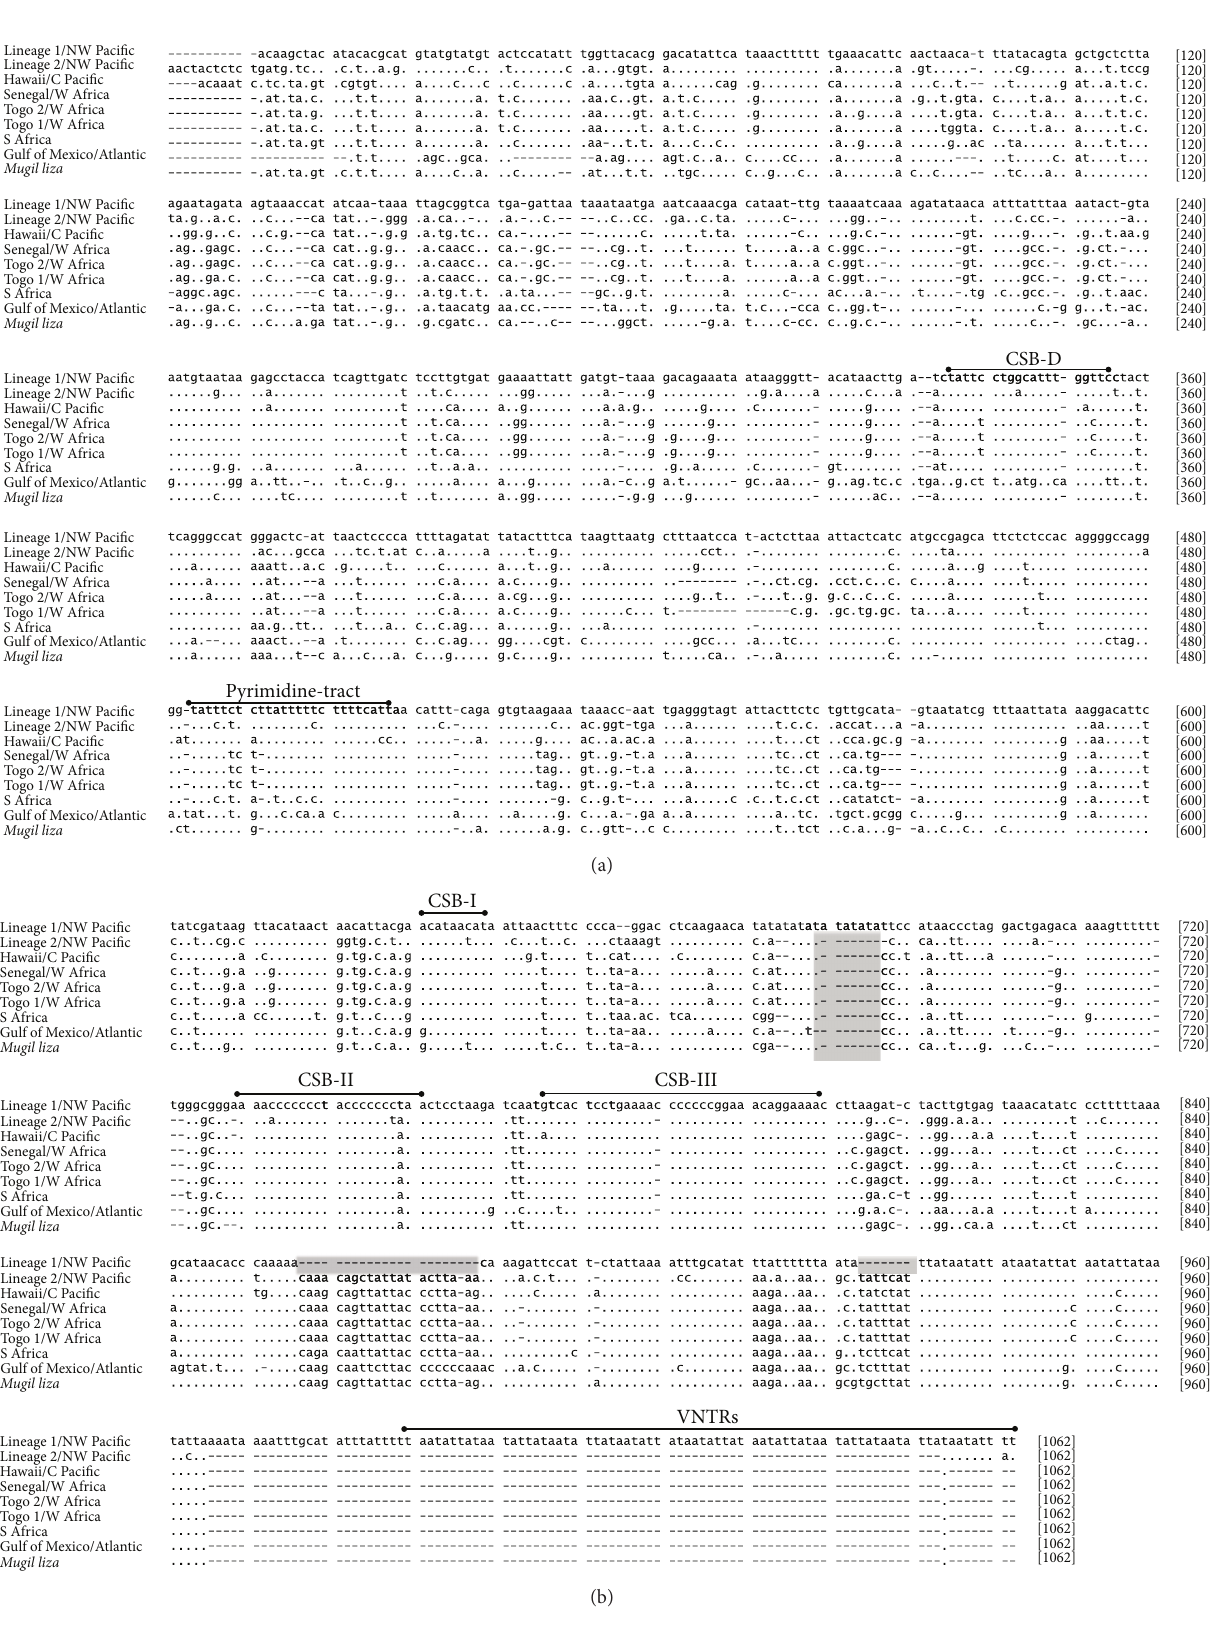
Figure 2: Multiple alignment of consensus sequences of Mugil cephalus from L1 (Lineage 1) and L2 (Lineage 2) of the NW (northwest) Pacific, Hawaii/C (central) Pacific, Gulf of Mexico/ Atlantic, Togo and Senegal/W (west) Africa, and South Africa. Structural features (CSB— conserved sequence block and Pyrimidine-tract) are also